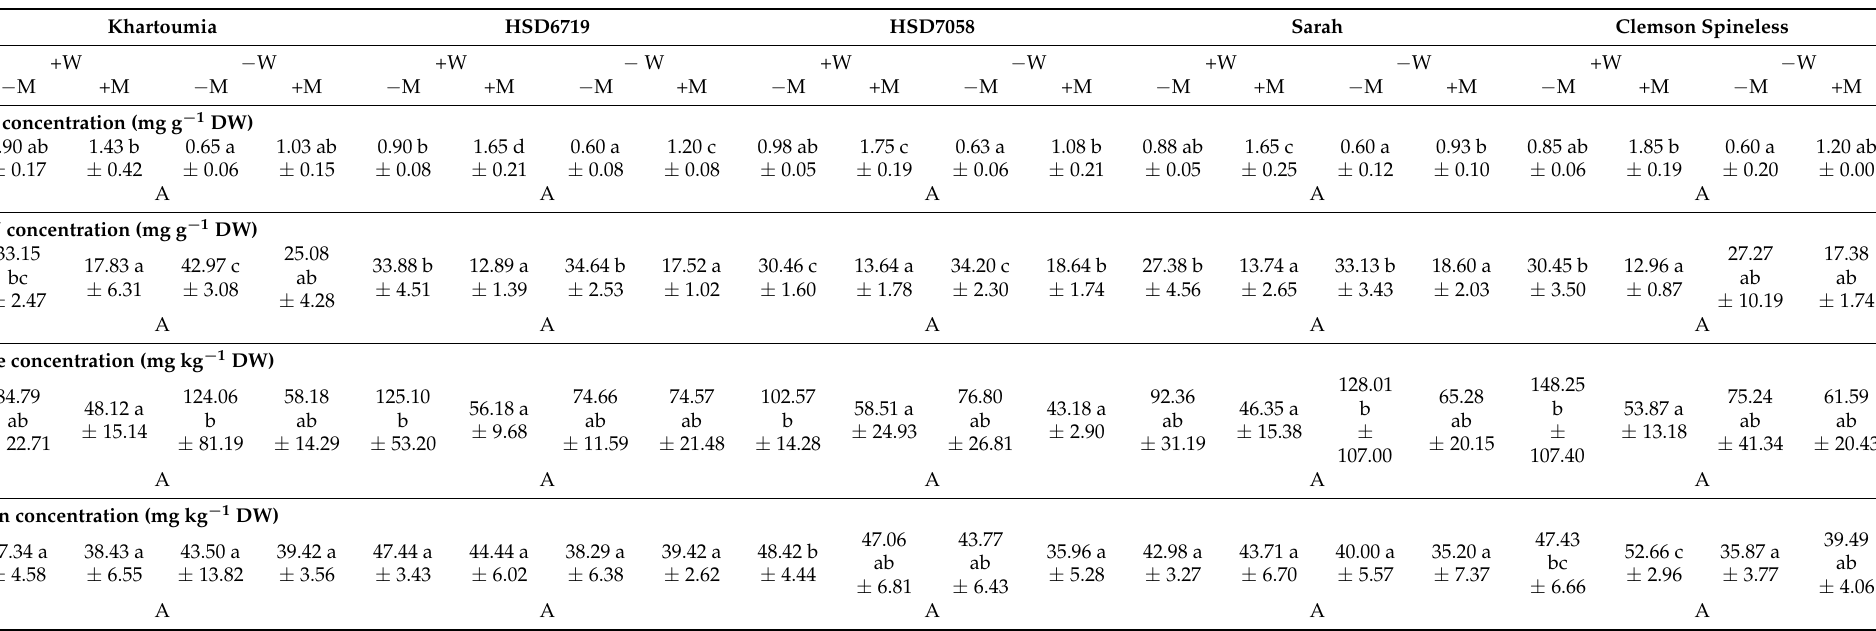
Table 2. Shoot concentration of P, N, Fe and Zn of five okra cultivars. Plants were non-inoculated ( − M) or inoculated (+M) with R. irregulare . Substrate water content was either maintained at 20% (+W) or 10% w / w ( − W). For statistics, refer to the text for Figure 3. Shown are mean values ± standard deviation. Within each cultivar mean values followed by the same small letter are not significantly different (Tukey’s test, n = 4, p < 0.05). Cultivars followed by the same capital letter are not significantly different (Tukey’s test, n = 4, p <